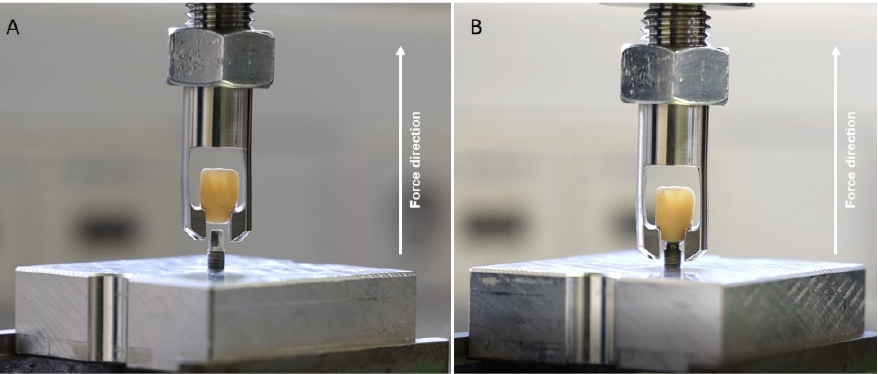
Figure 8. Detachment of the IAC assemblies during the pull-of leading to failure: ( A ) Sample from group H showed decementation; ( B ) sample from group C3 showed pull-off of the abutment.